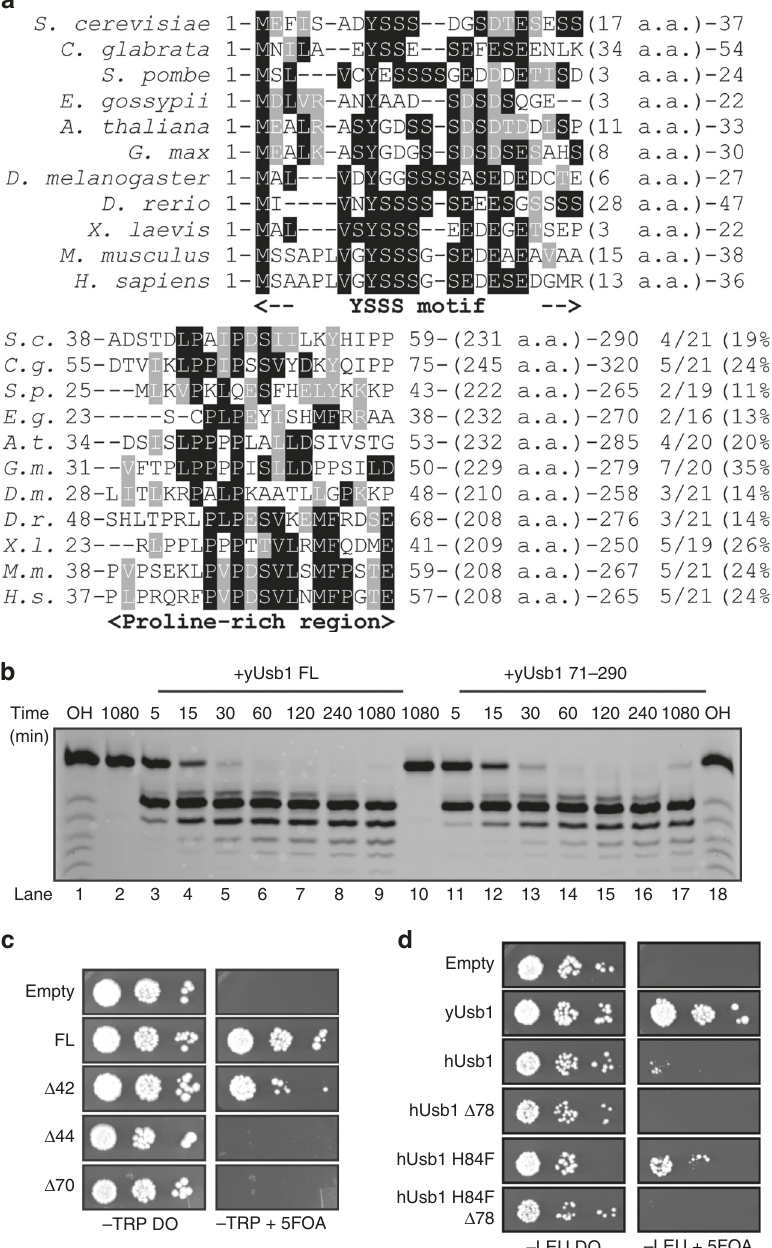
Fig. 4 Usb1 catalytic activity alone is not suf fi cient for yeast viability. a Sequence alignment of N-terminal regions of Usb1. While the length of the N-terminus is poorly conserved (ranging from 46 to 103 residues in length), two regions of sequence conservation exist near the N-terminus (with a conserved Y-poly S-(D/E) motif) and in the center of the N-terminal region (the proline-rich region). Proline composition of this region is indicated to the right of the alignment. b Time course comparing the activities of full-length Usb1 (lanes 2 – 9) and the catalytic domain (residues 71 – 290) (lanes 10 – 17) over the course of 18 h shows similar rate and extent of processing for both proteins. Alkaline hydrolysis ladders (lanes 1 and 18) show the mobility of oligonucleotide products of different length. c N-terminal truncated forms of Usb1 show different capacity to support complementation of USB1 Δ . Removing the fi rst 42 residues supports growth, whereas removing 44 residues or more does not. d hUsb1-H84F does not complement USB1 Δ if the homologous N-terminal region ( Δ 78) is